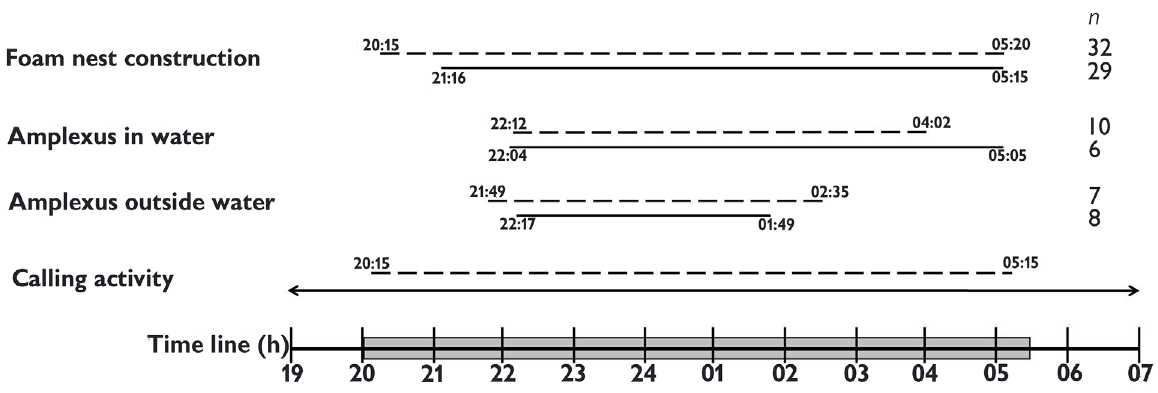
Figure 2. Timeline of the main behaviors of the reproductive activity of P. aff. albonotatus (continuous line) and P. santafecinus (intermittent line). The horizontal gray bar indicates night hours.